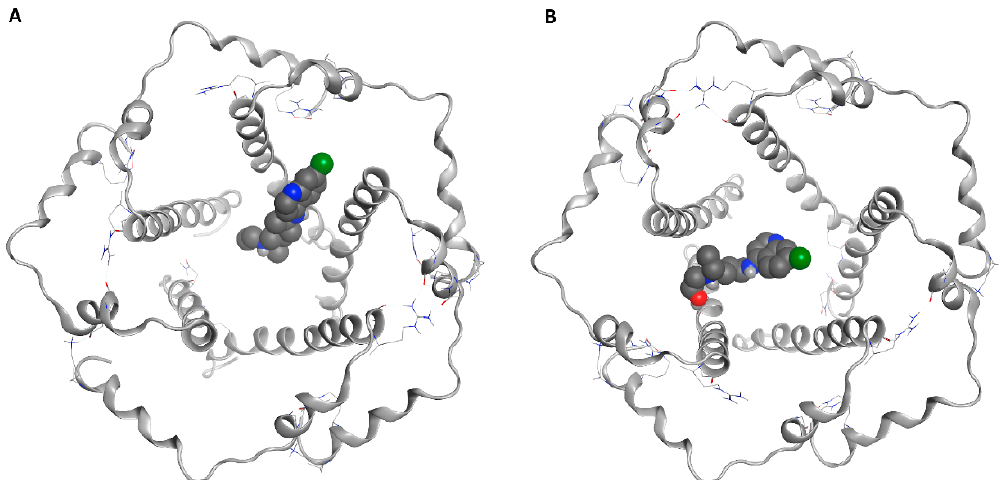
Figure 1. Docked poses of chloroquine (CQ) ( A ) and hydroxychloroquine (HCQ) ( B ) in the central cavity of the envelope (E) protein.